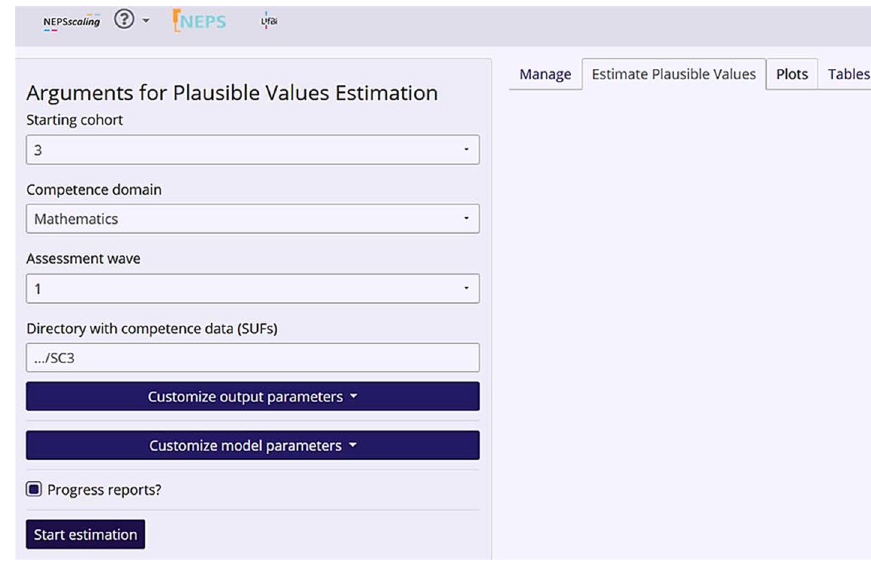
Fig. 3 Necessary input arguments for plausible values